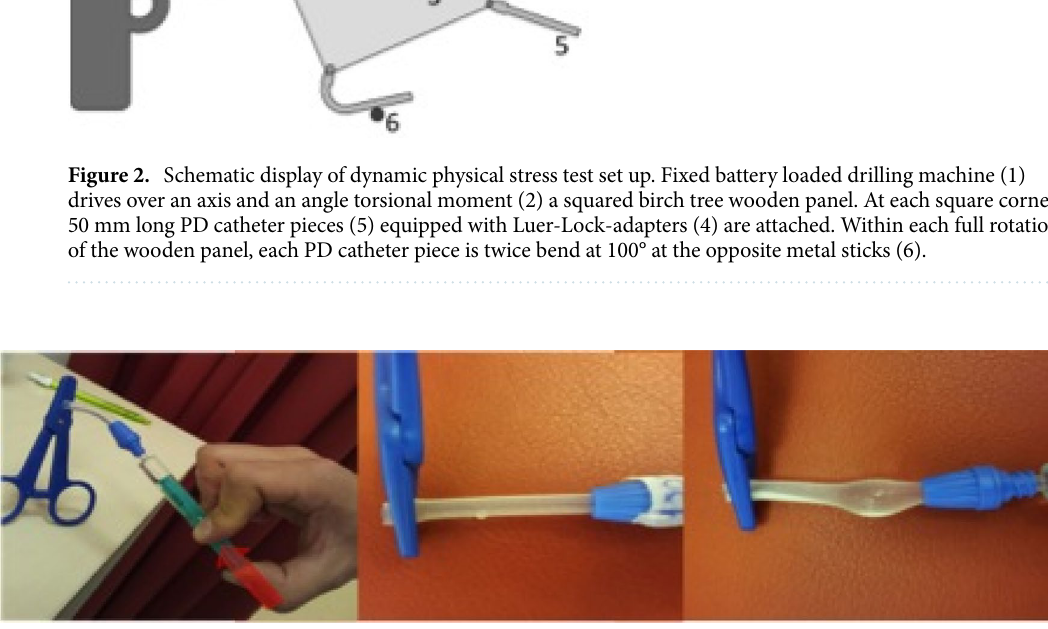
Figure 3. Intraluminal pressure exposure (left) to identify leakages such as e.g. liquid outlets (middle) and/or bulging